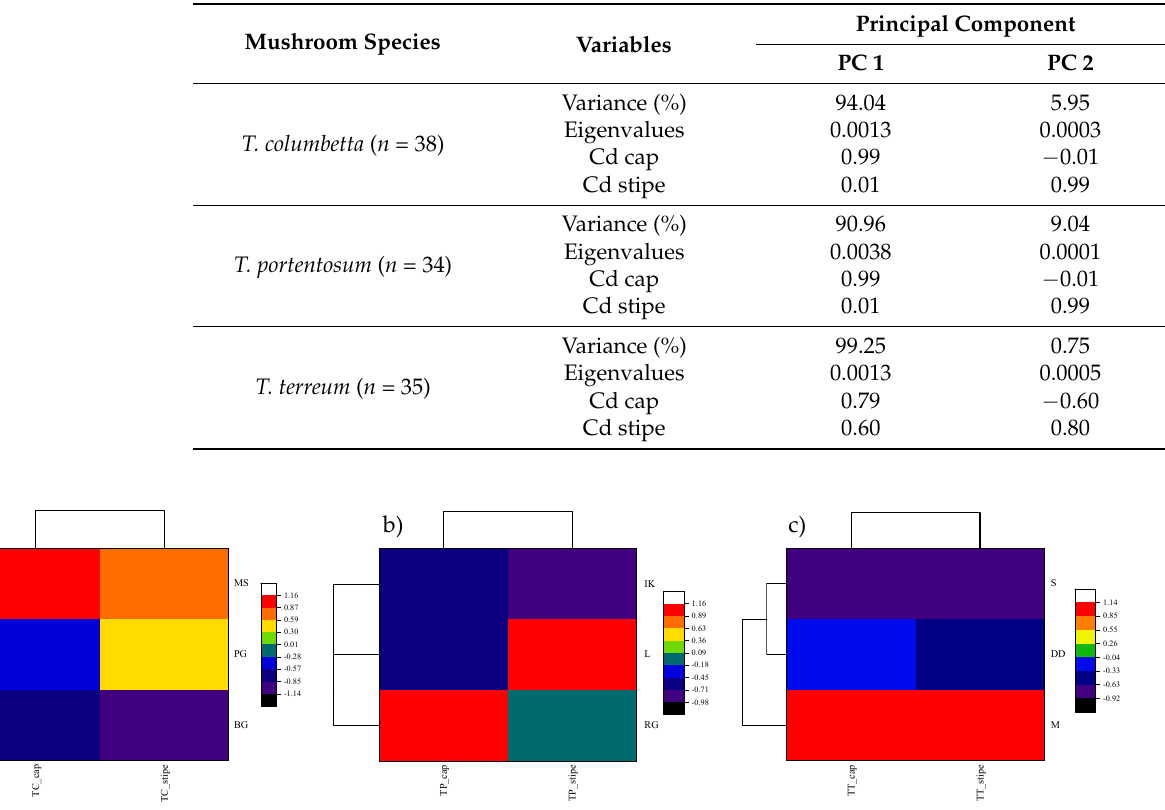
Table 3. PCA matrix for Cd concentration in cap and stipe parts of Tricholoma spp.